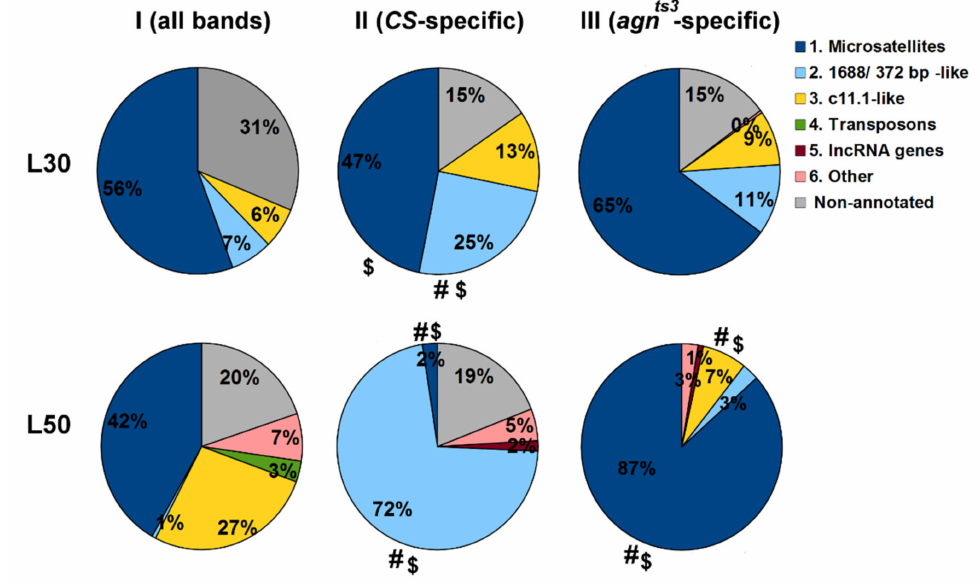
Figure 6. Short DNA fragments that contribute to FMF. Difference: # from I, non-annotated sequences included when calculating the proportions; $ from I, non-annotated sequences excluded (Chi-square test of two proportions; p < 0.05, n >